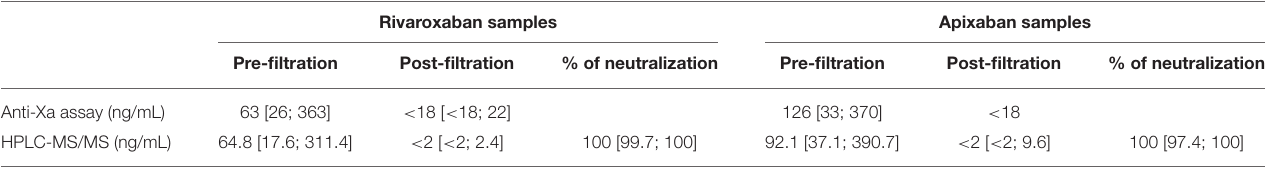
TABLE 1 | FXa inhibitors concentrations in pre- and post-filtration